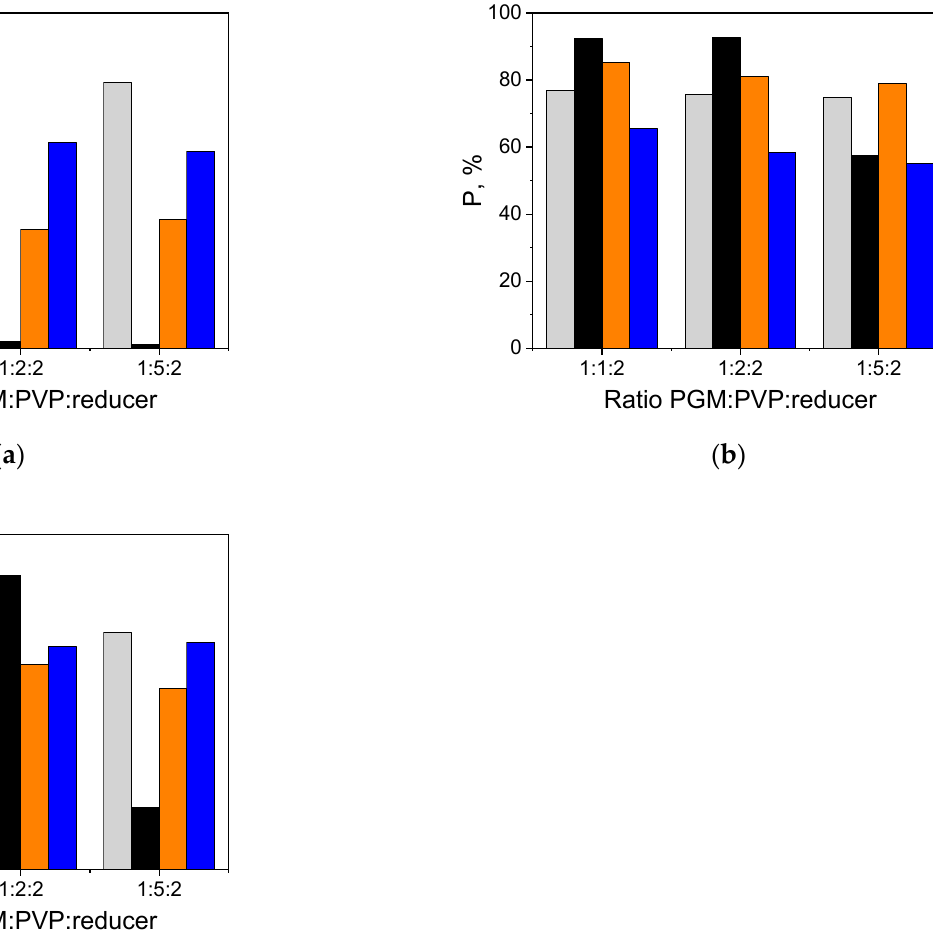
Figure 3. The effect of PVP concentration on the yield of ( ■ ) Pt-NP, ( ■ ) Pd-NP, ( ■ ) Rh-NP and ( ■ ) Ru-NP formation (the molar ratio of PGM:PVP:reducer was 1:1:2, 1:2:2 and 1:5:2, the reducer: ( a ) AA, ( b ) NaBH 4 , ( c ) HCOONa).